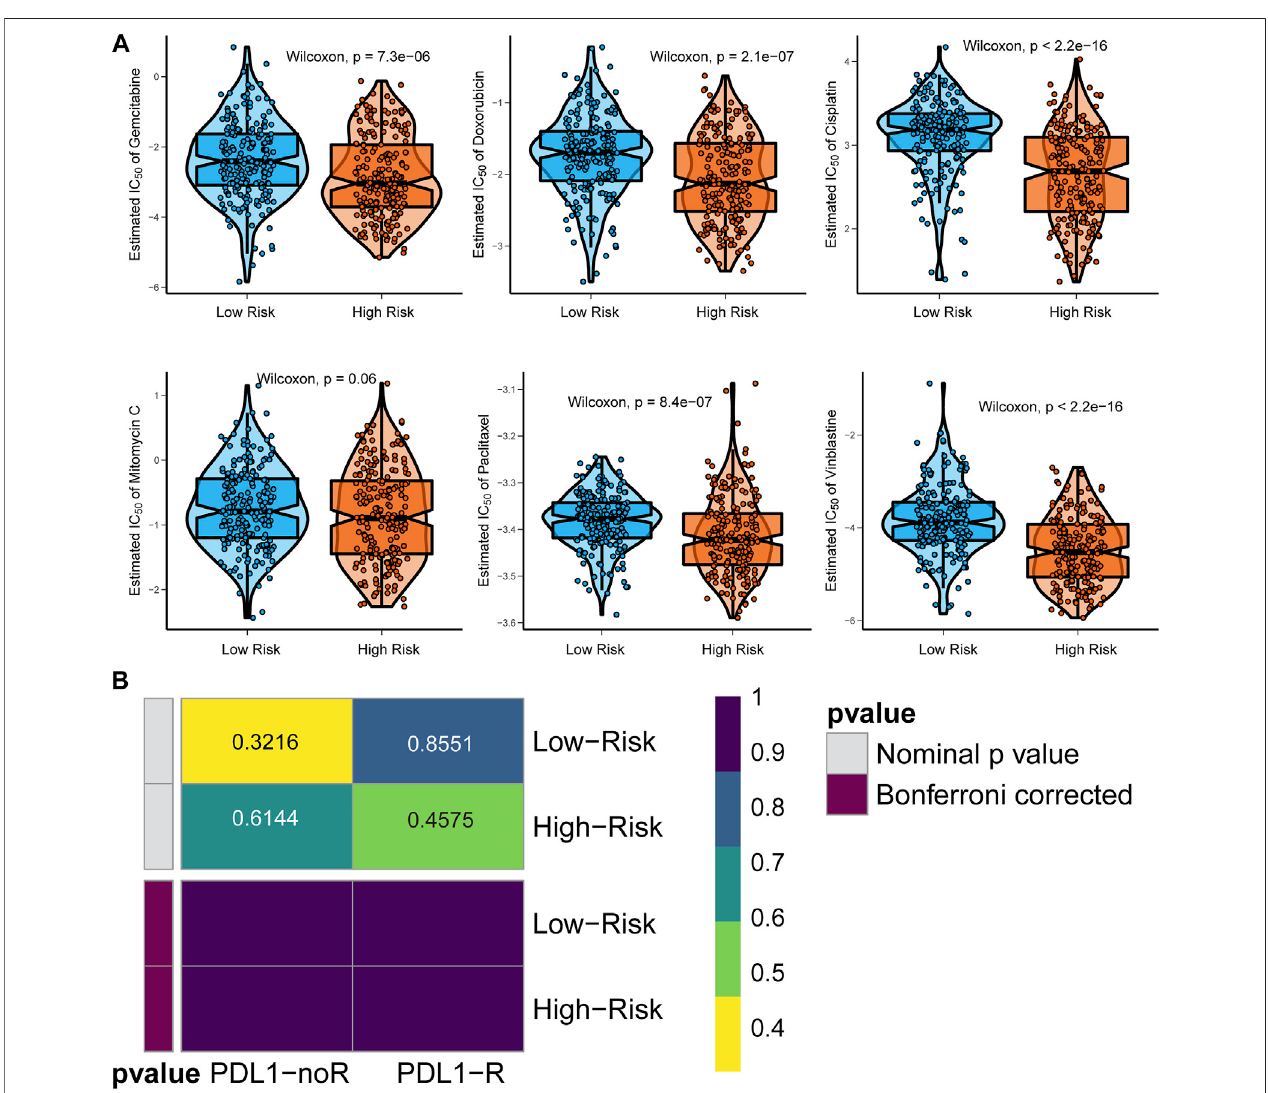
FIGURE7| Identi fi cation ofappropriatetargeted therapyforBCapatients. (A) Appropriate chemotherapyforsignature-de fi nedhigh-riskandlow-riskpatients. (B) Appropriate anti-PD-L1 immunotherapy for signature-de fi ned high-risk and low-risk patients.